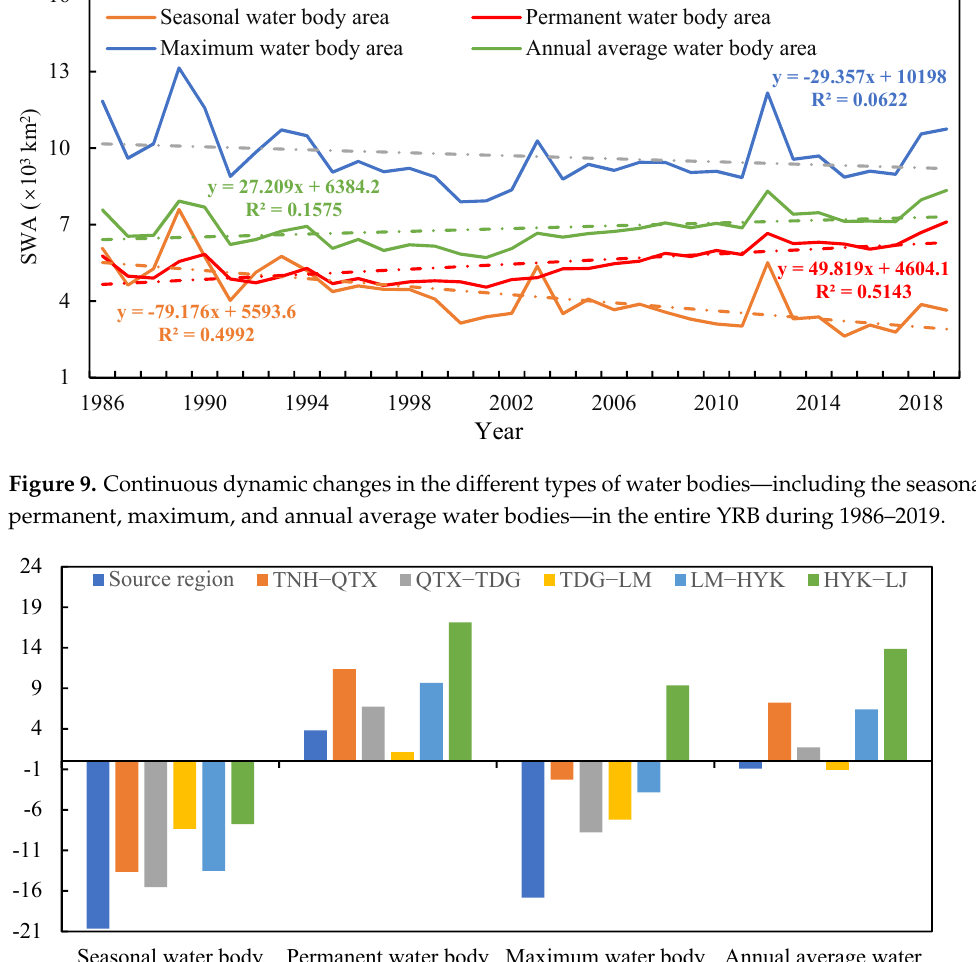
Figure 11. Changes in the different types of water bodies in each sub-basin in the YRB during 1986– 2019. Panels ( a – d ) are for the permanent, seasonal, maximum, and annual average SWAs, respectively.